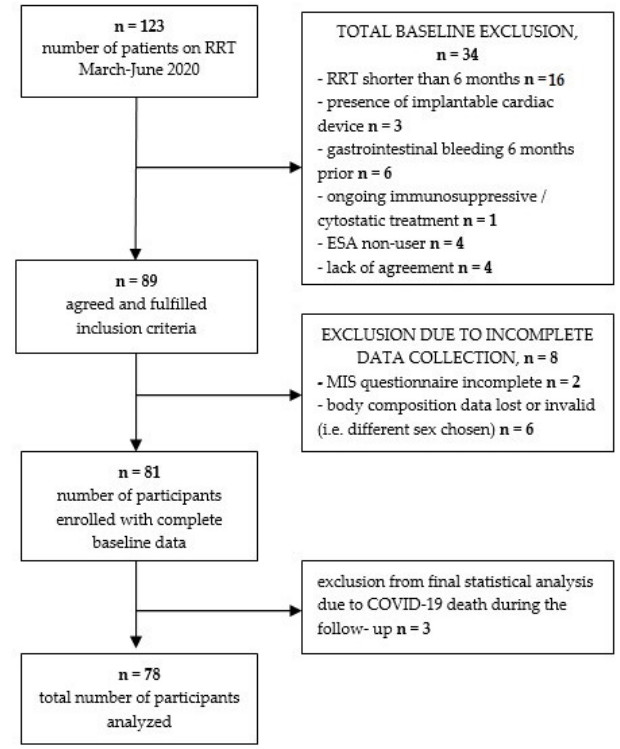
Figure 1. Study group recruitment.